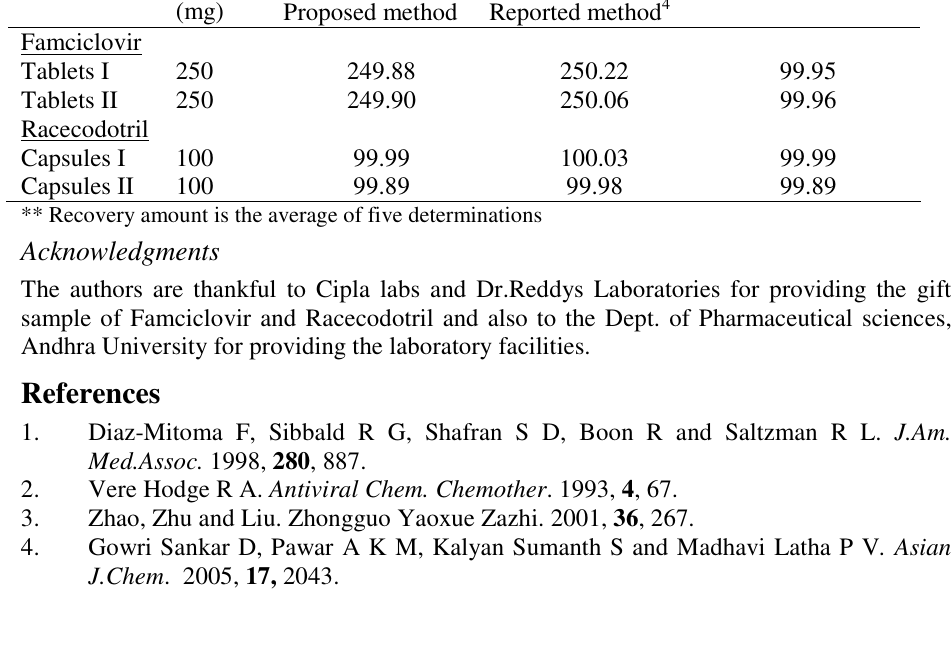
Table 2 Assay and recovery of FCV and RCD in dosage forms Content of drug found (mg) Name of